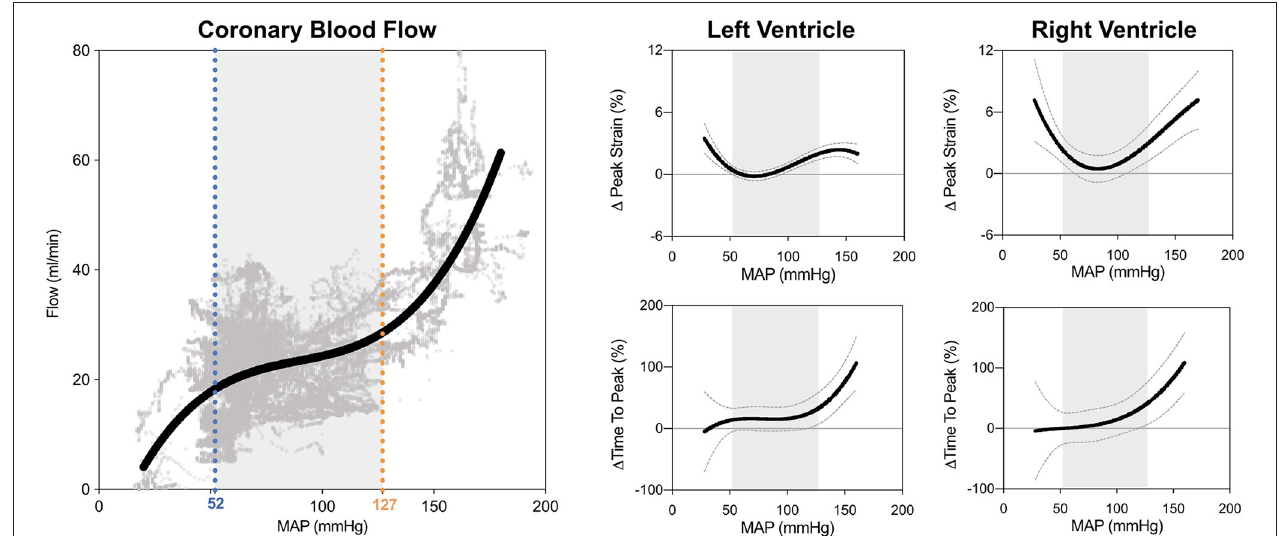
FIGURE 2 | Biventricular systolic strain measures in relation to blood pressure. The limits of the coronary autoregulation zone (ARZ) as calculated from invasive flow measurements are shown on the left. Non-linear relationships and 95% confidence intervals of the fit are shown between mean arterial blood pressure (MAP) and peak circumferential strain and time to peak strain for the left ventricle (middle) and right ventricle (right). Gray shading depicts the